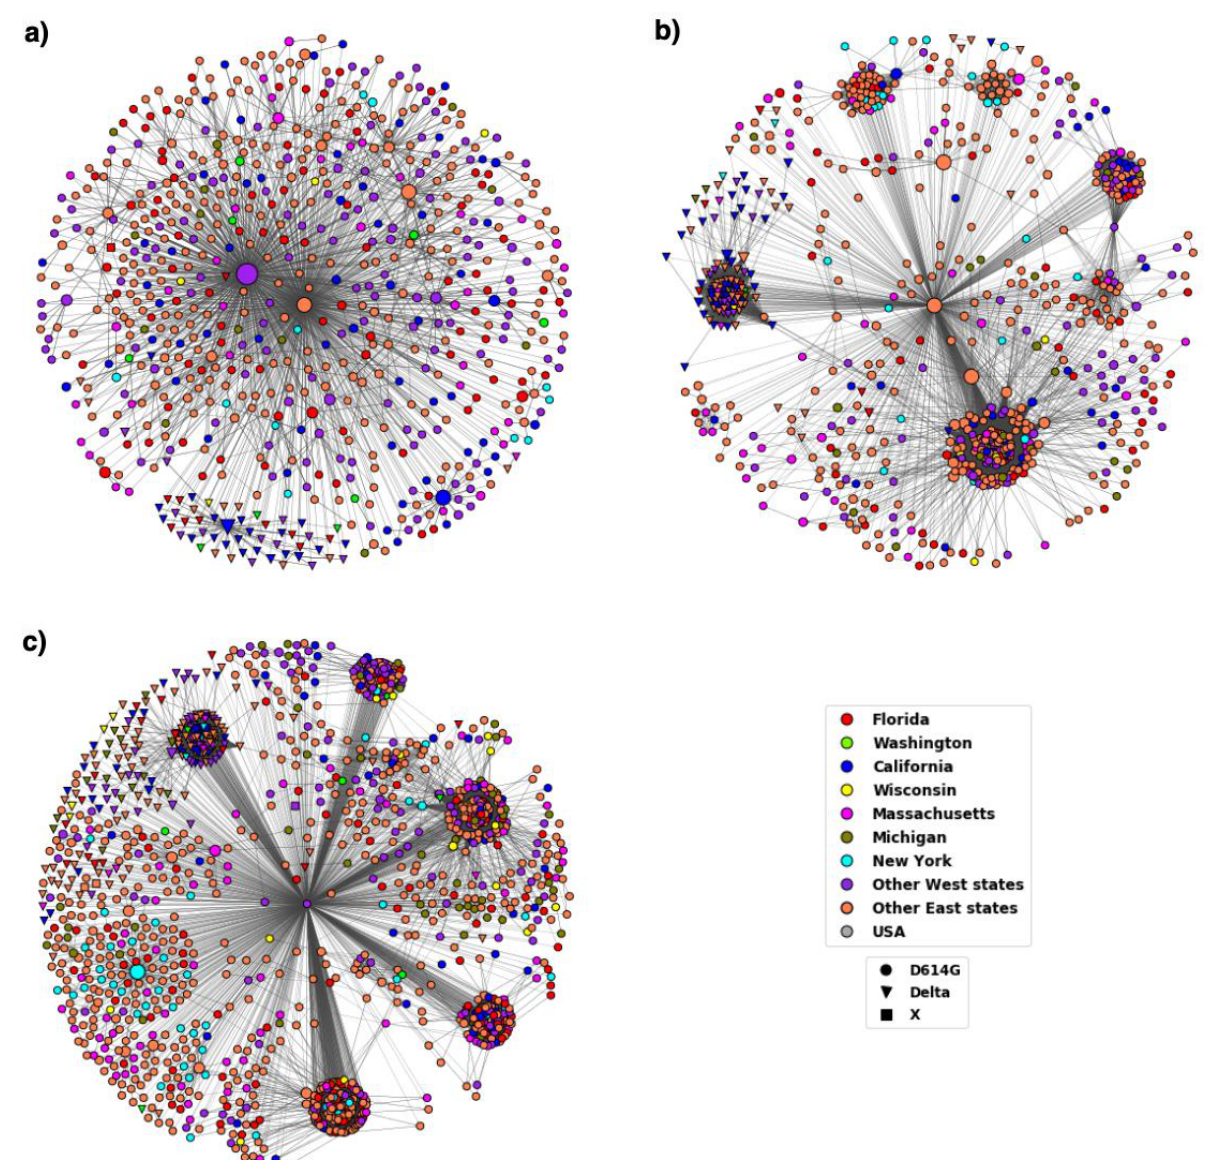
Figure 5. DiWANN networks for periods T6–T8. ( a ) The network for T6 comprised of 688 nodes, ( b ) T7 comprised of 736 nodes, ( c ) T8 comprised of 1478 nodes. The shape of the node corresponds to the variant and the node color to the location as depicted by the legend. Nodes labelled as ‘USA’ did not have location information. The inverted triangular nodes have characteristic Delta variant mutations whereas the circular nodes might have other mutations in the established D614G variant.